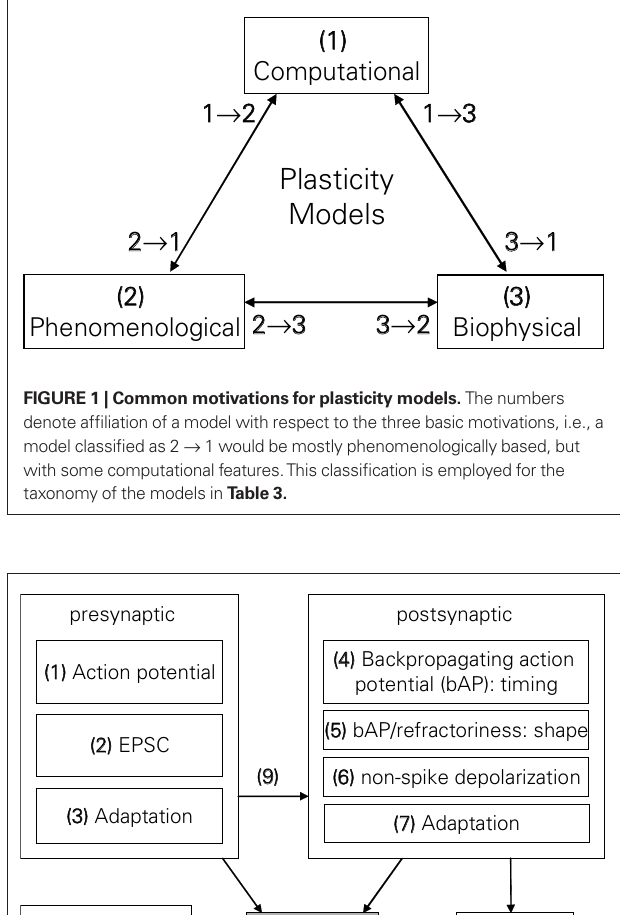
Figure 2 . The next level of detail in presynaptic mechanisms of